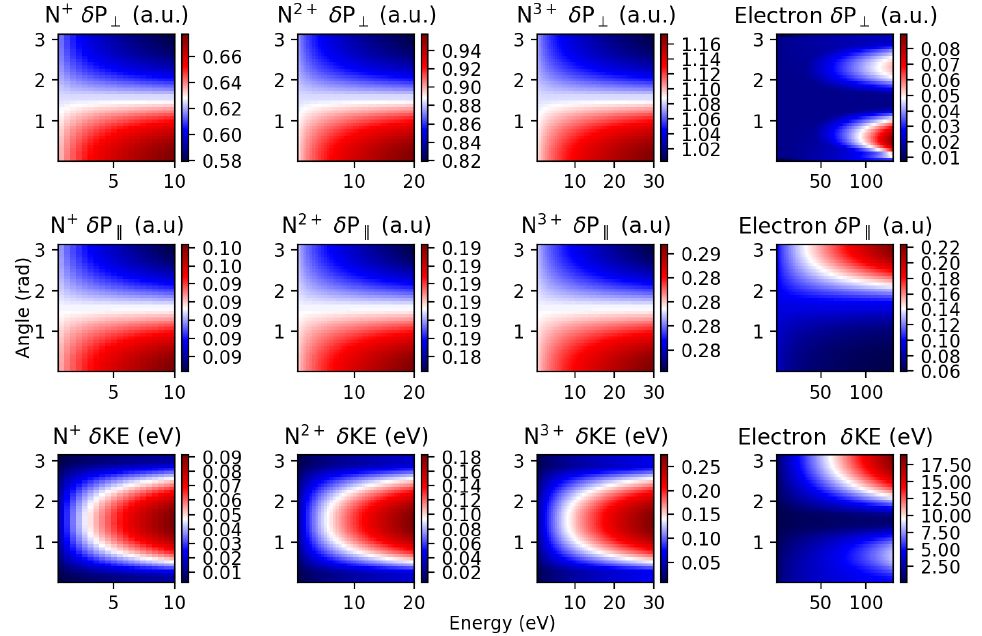
Figure 13. Ion and electron momentum and energy resolution with the spectrometer setting as defined in Figure